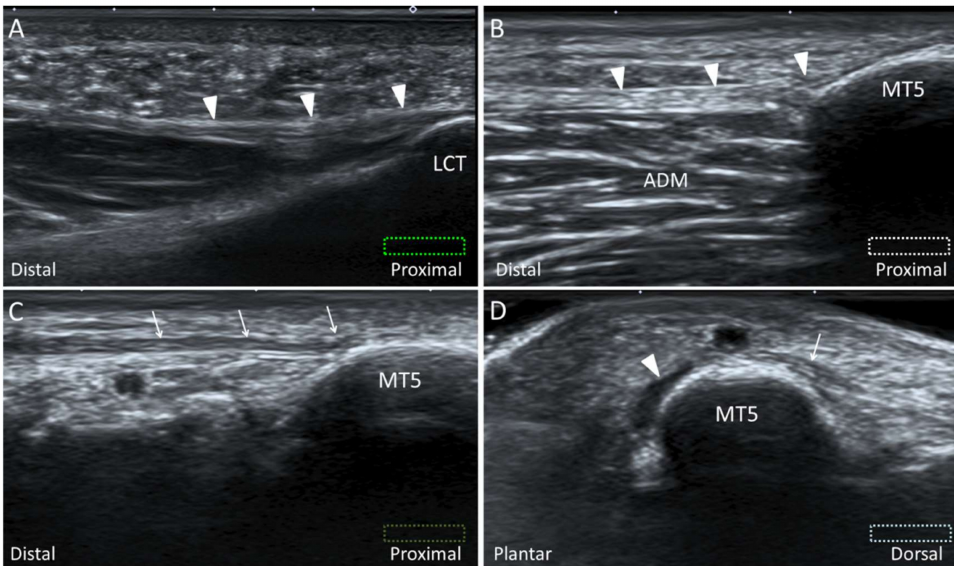
Figure 15. Imaging of the lateral cord (arrowheads) of the plantar fascia at the proximal origin ( A ) and distal attachment ( B ). Moving the transducer dorsally, the peroneus brevis tendon (arrows) is also visualized attaching on the fifth metatarsal base (MT5) ( C ). The short axis imaging demonstrates the anatomic relationships between the lateral cord of plantar fascia and the peroneus brevis tendon ( D ). The colored dashed rectangles are in accordance with the transducer positions in Figures 2A and 3B. ADM: abductor digiti minimi; LCT: lateral calcaneal